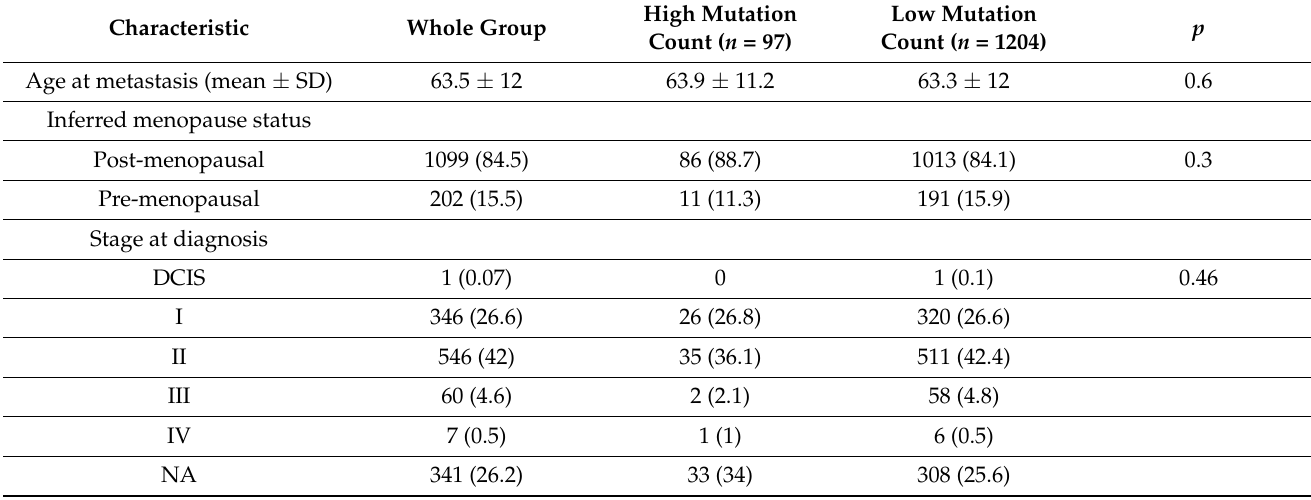
Table 4. Characteristics of the high and low mutation count groups in patients with